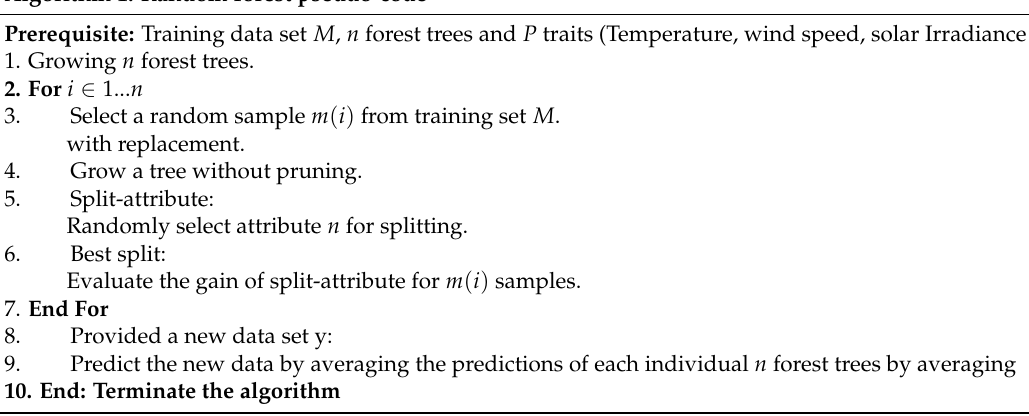
Algorithm 1 outlines the pseudo-code procedure of the random forest algorithm. Algorithm 1: Random forest